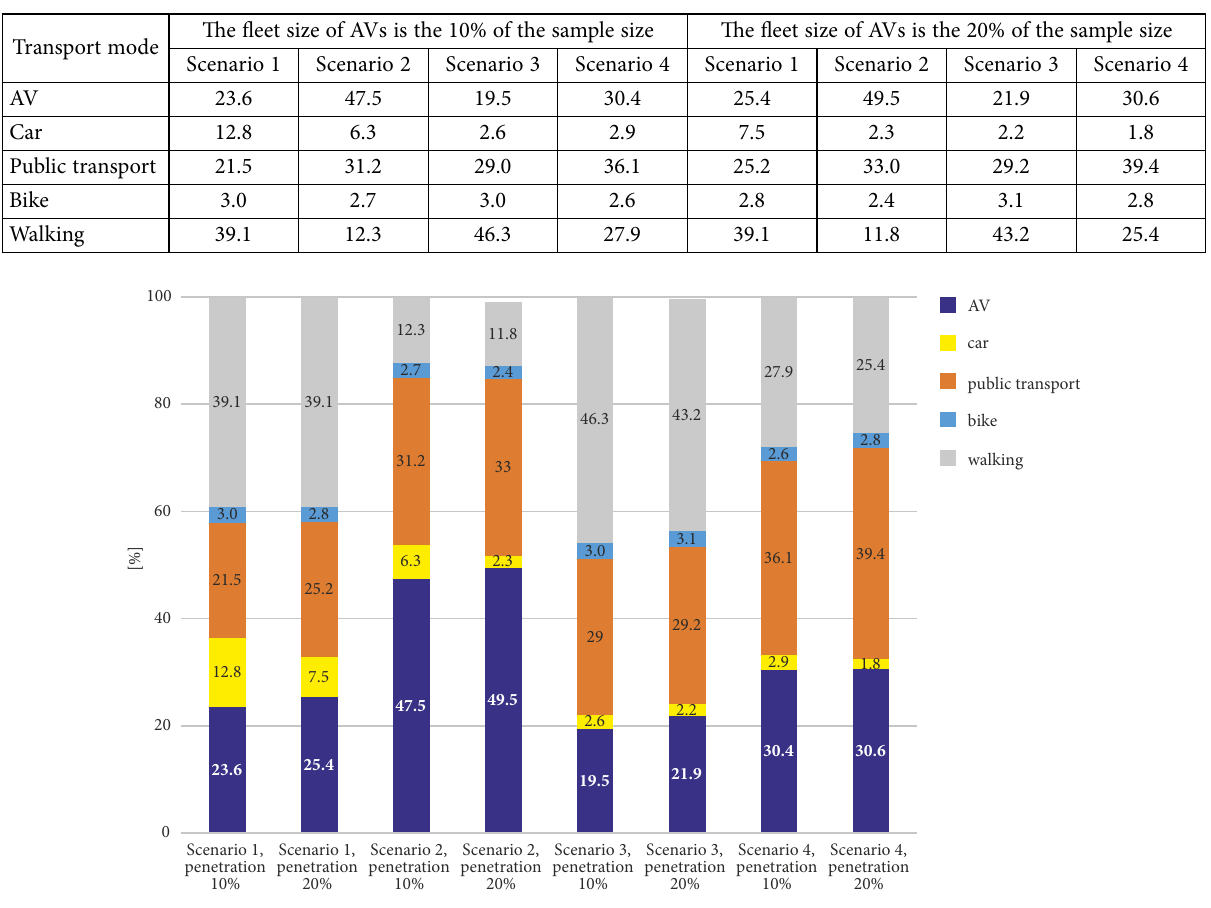
Table 5. The mode-share shift results of the simulations